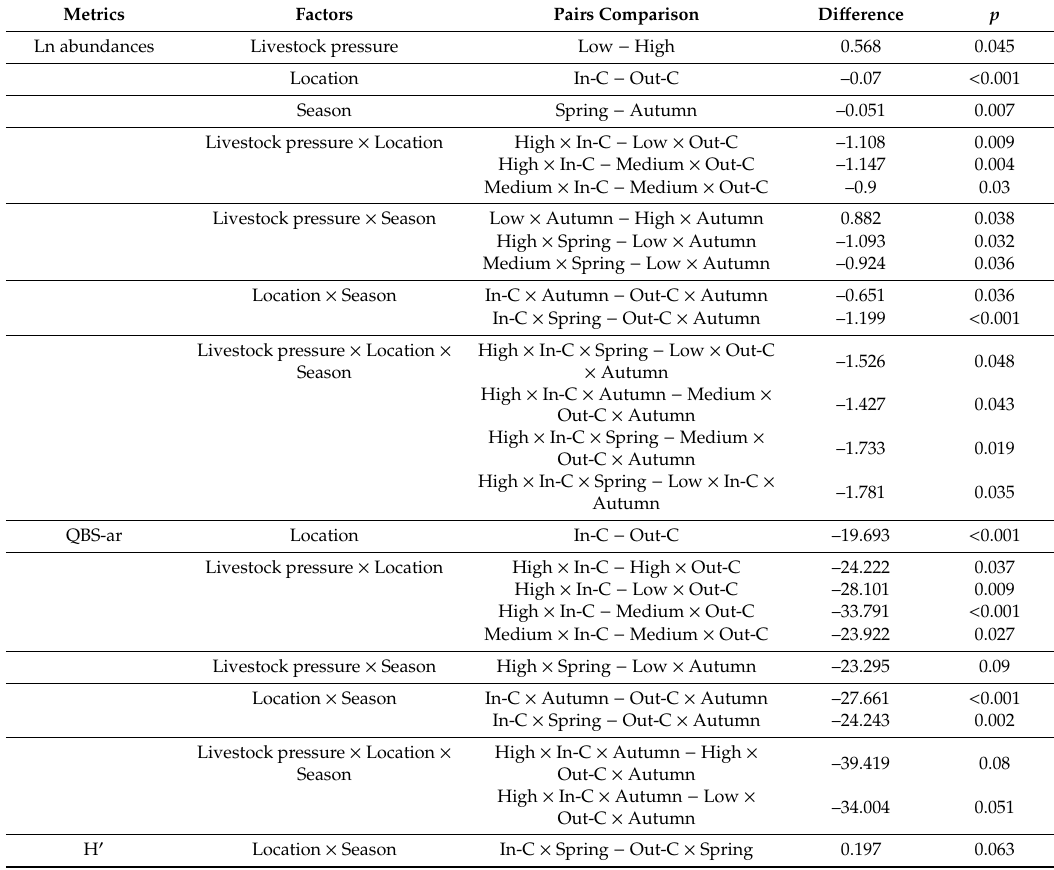
Table A3. Significant comparisons from post hoc Tukey tests are shown.